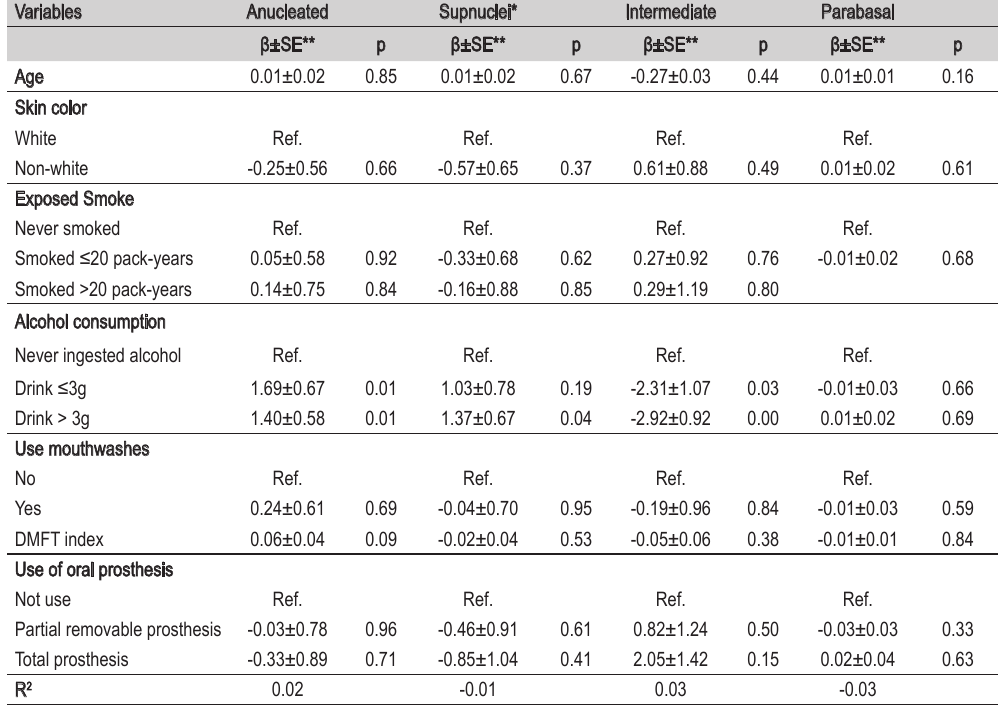
Table 4 - Multivariate linear regression model of the association between the percentage of cells at the border of tongue and the independent variables.